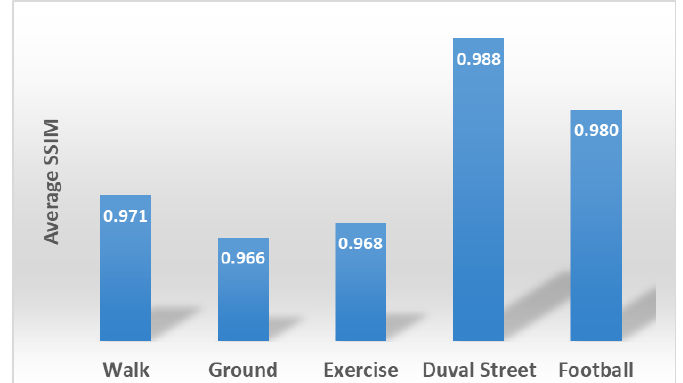
Figure 11. Average Structural Similarity (SSIM) between original frames at the sender and reconstructed frames at the receiver for five video